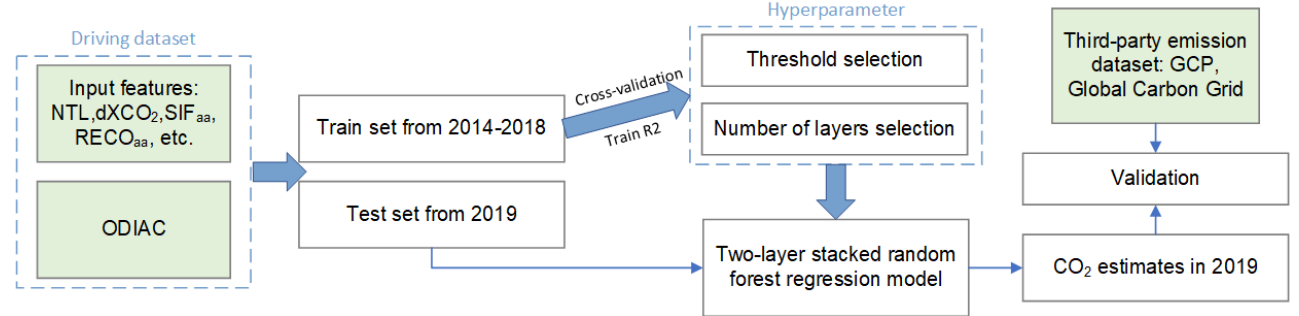
Figure 2. The general flowchart of estimating CO 2 emissions using a data-driven stacked random forest regression model.